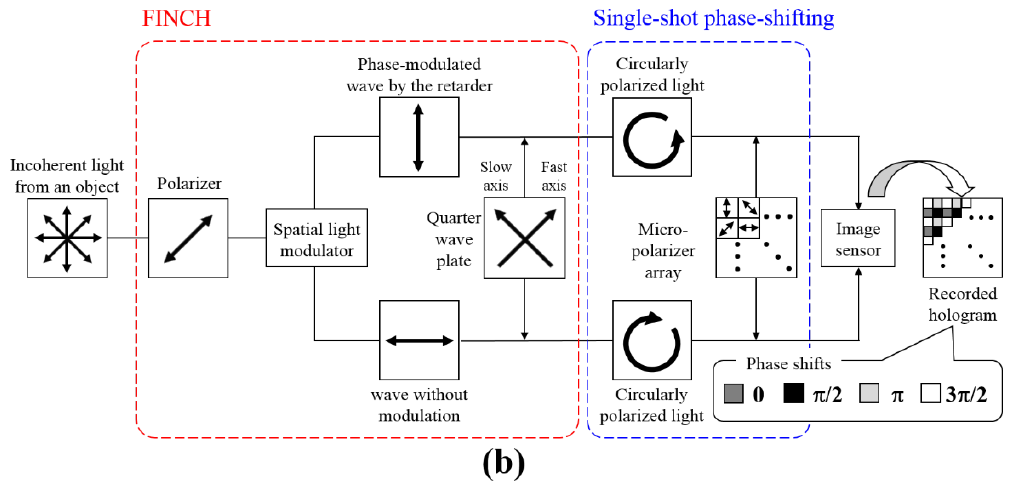
Figure 8. Single-shot in-line phase-shifting digital holography (DH) with Fresnel incoherent correlation holography (FINCH). ( a ) Schematic of a constructed optical setup. ( b ) Transitions of the states of polarizations.